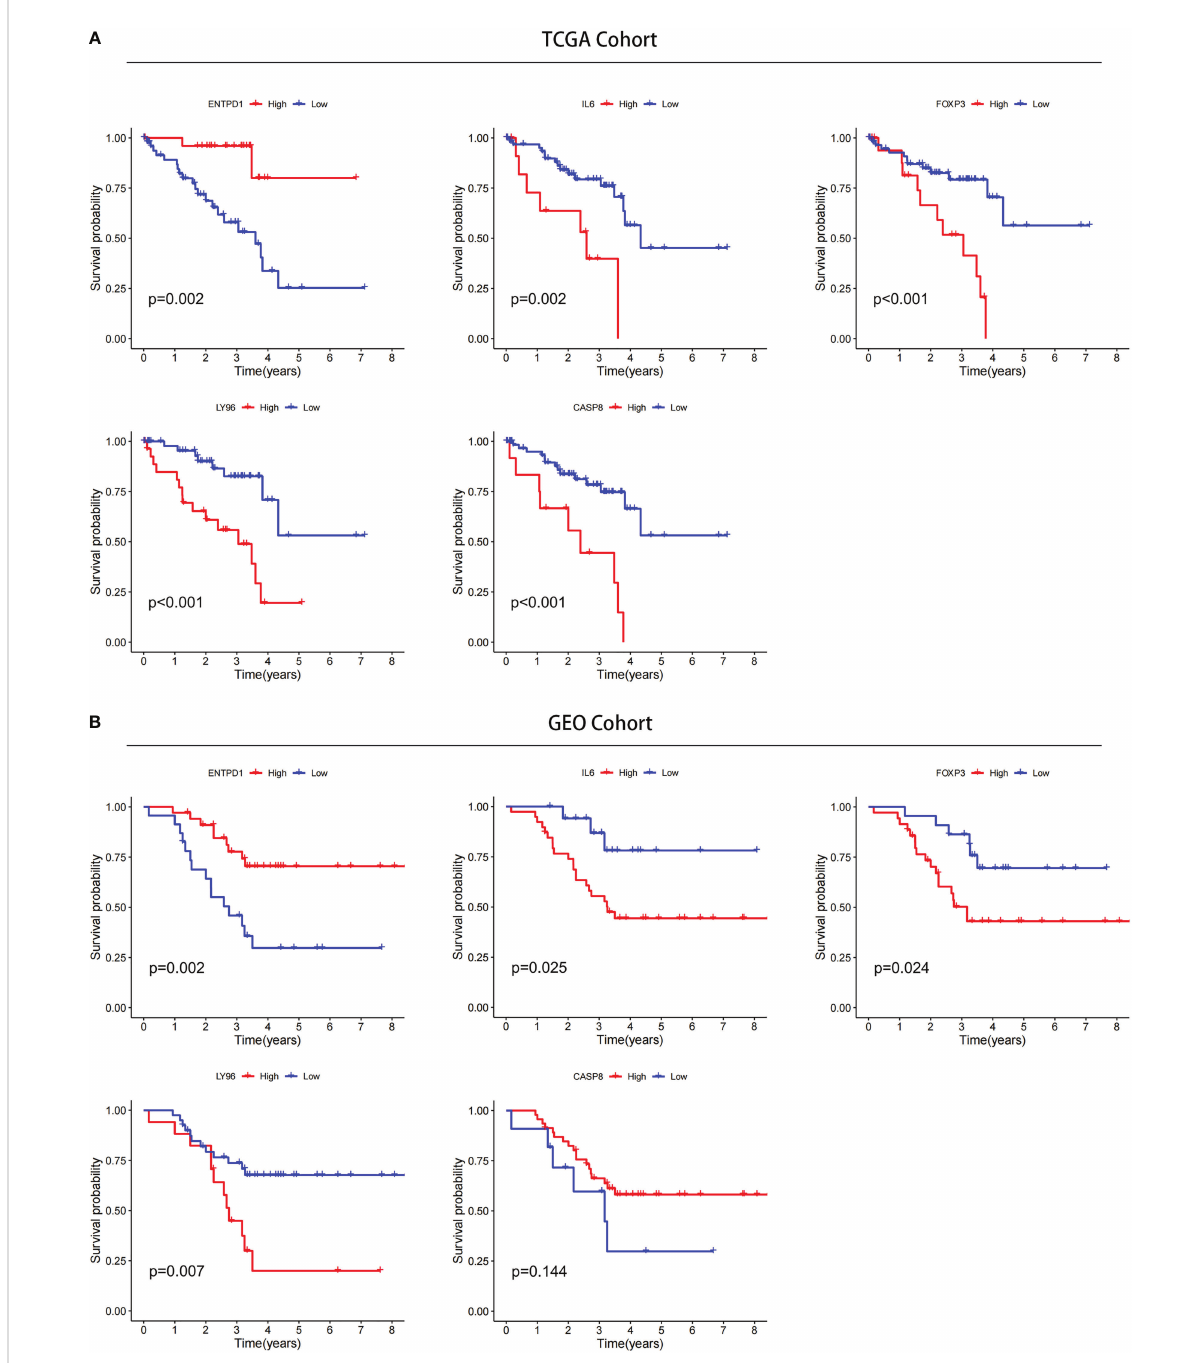
FIGURE 12 Con fi rmation of prognostic value of 5 ICD-related genes in TCGA and GEO databases. (A) Kaplan – Meier analysis of 5 ICD-related risk genes for patients in TCGA. (B) Kaplan – Meier analysis of 5 ICD-related risk genes for patients in GEO